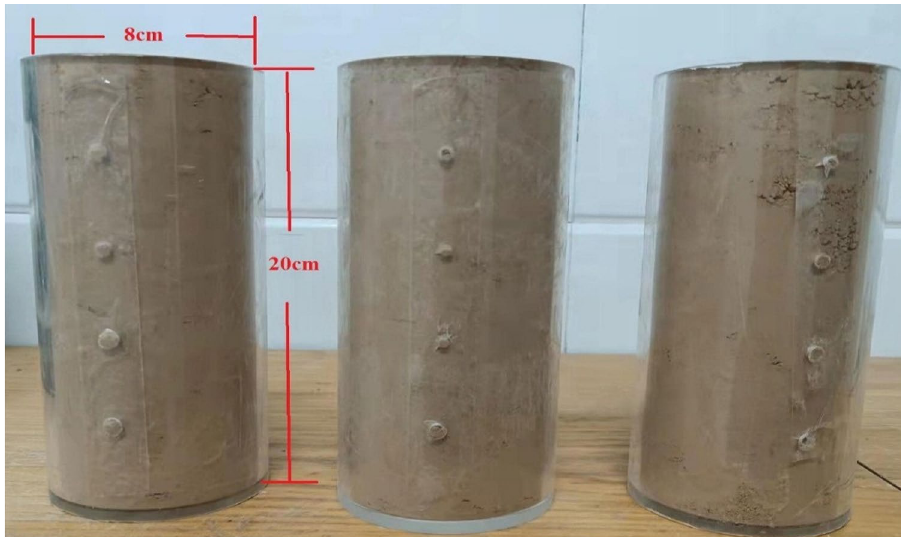
Figure 6. Reconstituted